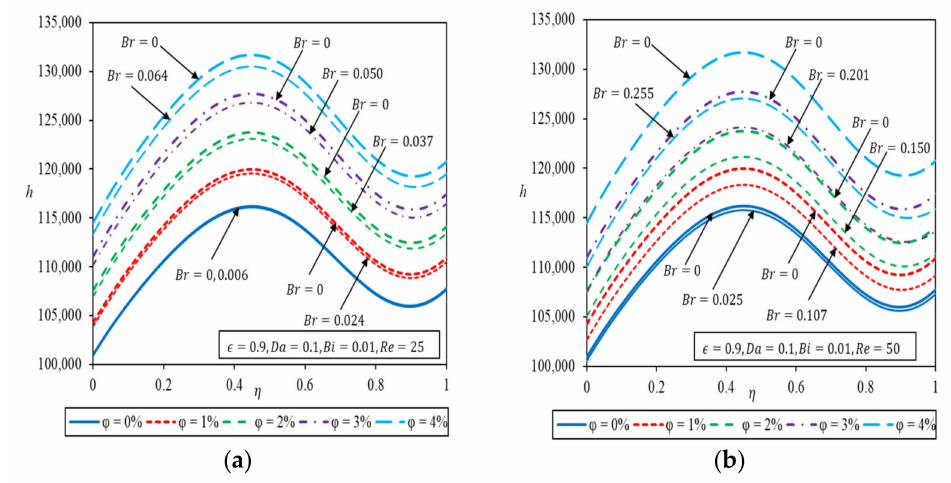
Figure 7. Heat transfer coefficient as a function of porous medium thickness with different volume fractions of Al 2 O 3 -Water nanofluid ( a ) Re = 25 ( b ) Re = 50.